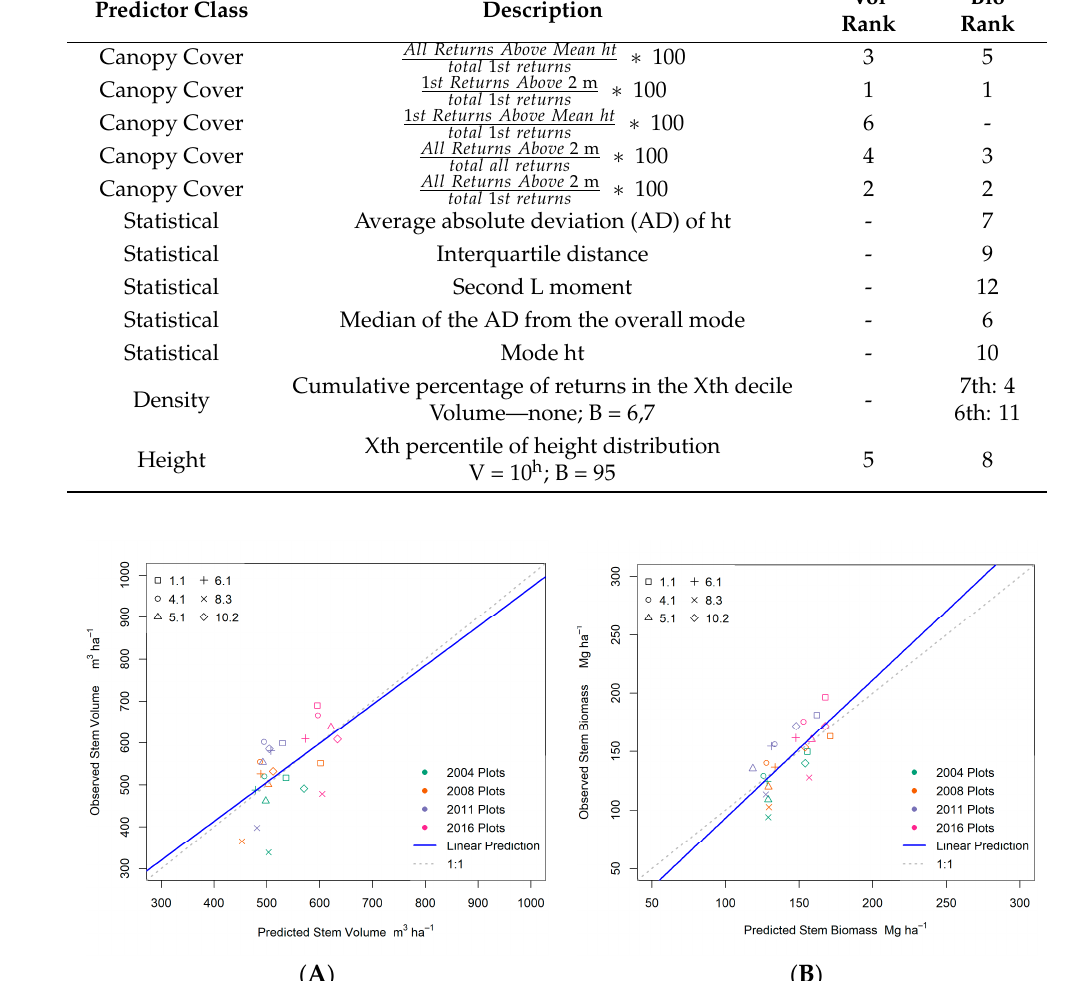
Table 4. LiDAR metrics selected and relative importance ranking for the volume (V, Vol) or biomass (B, Bio) models using Boruta variable selection method.